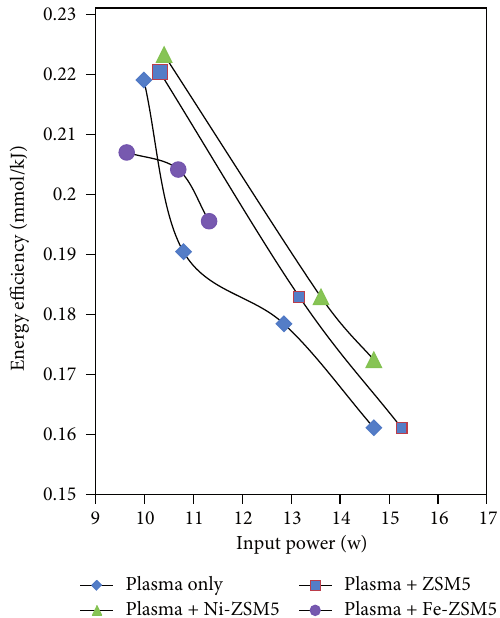
F 9: Energy efficiency versus input power supplied to the reactor.